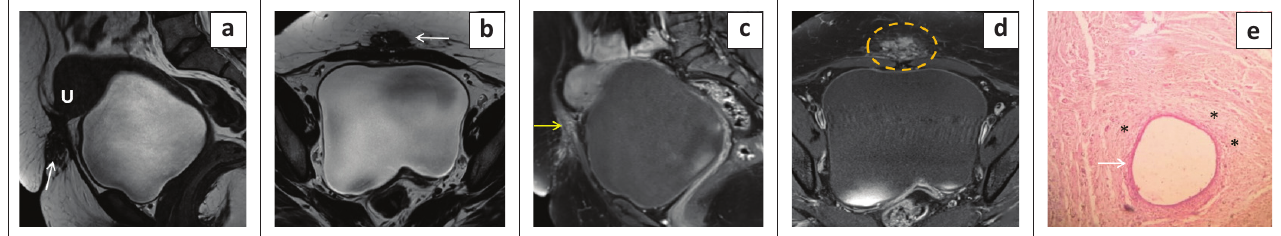
FIGURE 5: (a–e) Sagittal (a) and axial (b) T2 W images show an ill-defined hypointense mass (arrows) in the subcutaneous tissue and underlying right rectus muscle with a few T2W hyperintense foci. The fundus of the uterus (U) was also adherent to this site. Sagittal (c) and axial (d) post contrast images show avid enhancement of the lesion and the underlying rectus muscle (yellow arrow). Photomicrograph specimen (magnification-40 ×) with haematoxylin and eosin-stain (e) shows endometrial glands (arrow) with surrounding fibrous stroma (asterisks), confirming endometriosis.